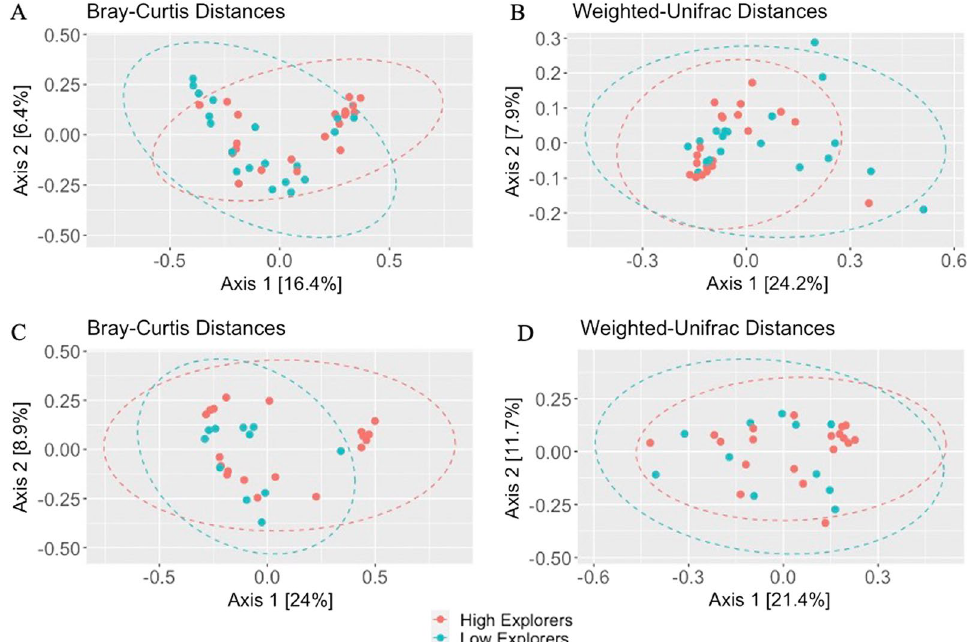
Fig. 2 Principal coordinate analysis of pre-captivity ( A ) Bray–Curtis ( B ) weighted UniFrac distances and post-captivity ( C ) Bray–Curtis ( D ) weighted UniFrac distances between the gut microbiomes of high (red) and low (blue) explorer birds. Each point represents a different individual. Circles indicate 95% confidence